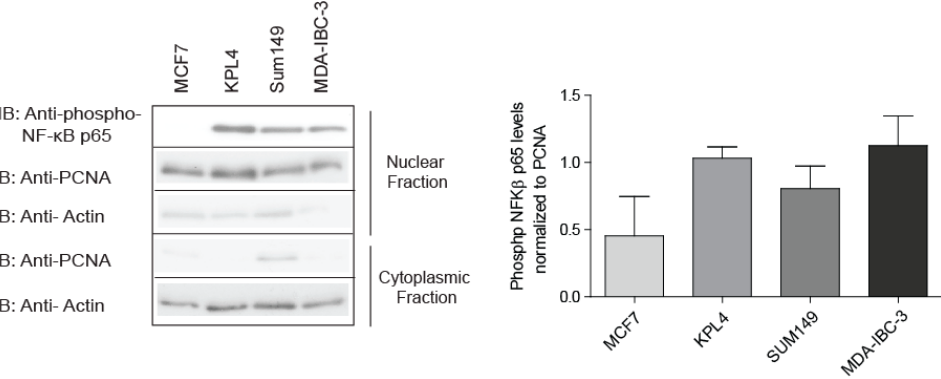
Figure 1. NF- κ B (nuclear factor kappaB) activity in inflammatory breast cancer (IBC) cell lines. Equal concentrations of total protein from nuclear or cytoplasmic extracts were loaded into a gel and immunoblotted (IB) with the phospho-NF- κ B p65 antibody that recognizes the p65 subunit phosphorylated at S536. PCNA (Proliferating cell nuclear antigen) expression is used as a control for nuclear fraction, and Actin is used as a control for cytoplasmic fraction. Signal was developed using enhanced chemiluminescence (ECL). Data shown are representative of the results of at least three independent experiments.